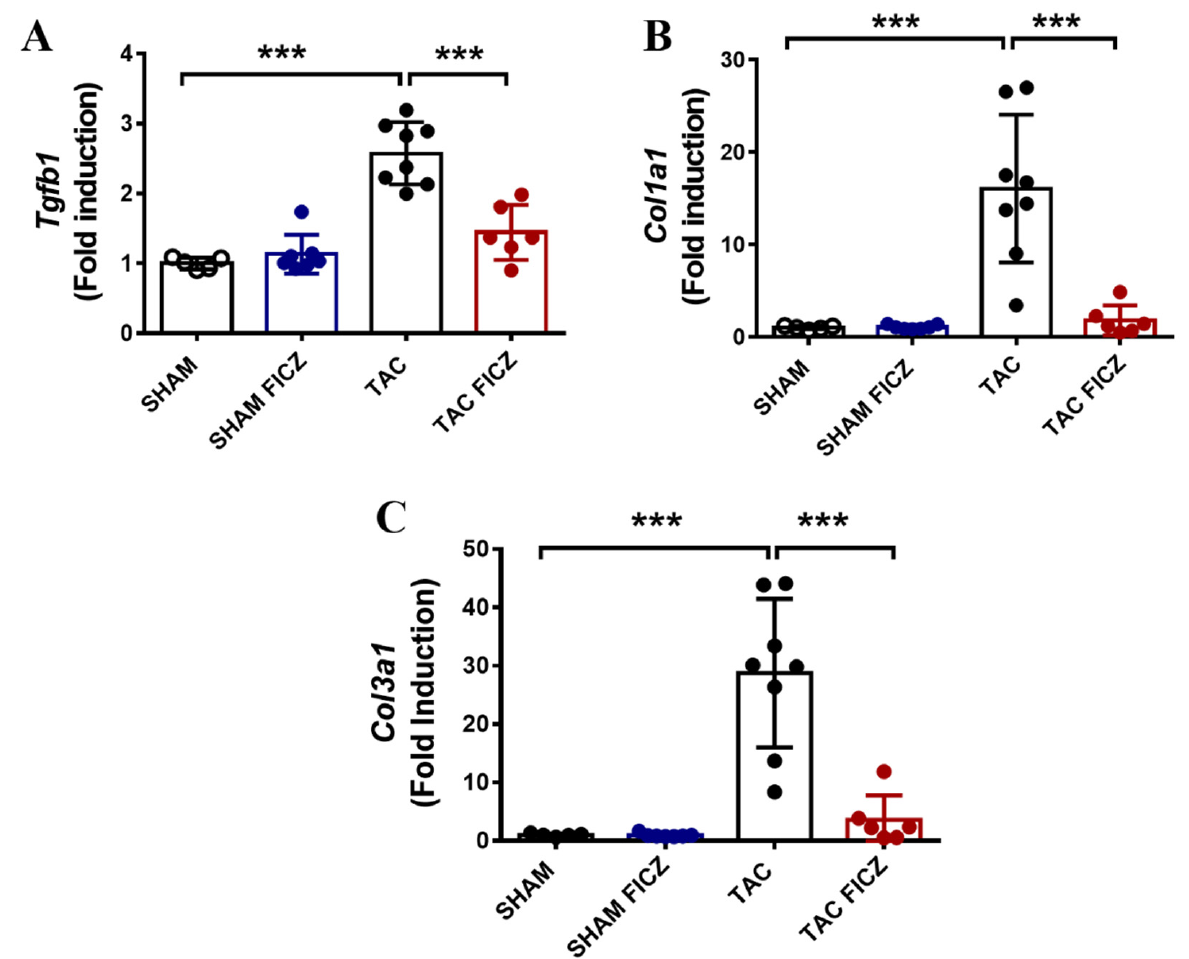
Figure 5. FICZ treatment prevents the increased expression of transforming growth factor beta 1 ( Tgfb1 ), collagen type I alpha 1 ( Col1a1 ), and collagen type III alpha 1 ( Col3a1 ) in mice subjected to TAC surgery. Real-time PCR analysis of mRNA expression of Tgfb1 ( A ), Col1a1 ( B ), and Col3a1 ( C ) normalized to that of the Rplp0 housekeeping gene. Groups are: Sham (open circles) ( N = 5), Sham FICZ (blue circles) ( N = 7), TAC (black circles) ( N = 8) and TAC FICZ (red circles) ( N = 6). Data are expressed as mean ± SD. *** p < 0.001.